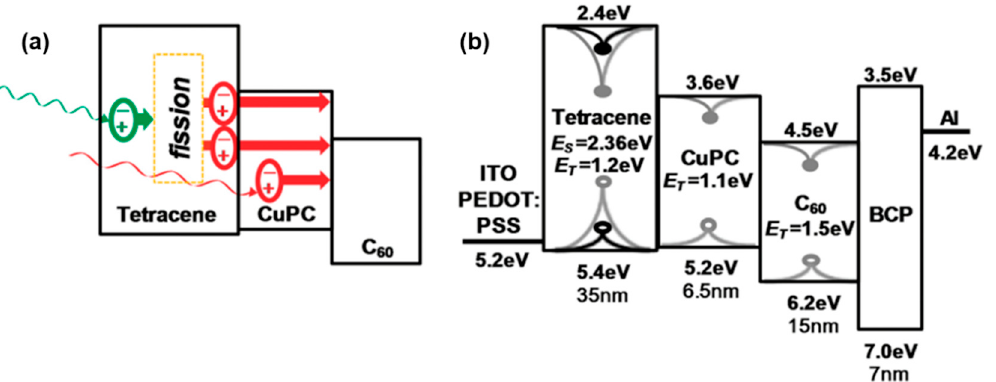
Figure 14. ( a ) Schematic of a photovoltaic exhibiting the SF process. ( b ) Complete structure of the photovoltaic cell. Reprinted with permission from Ref. [95]. Copyright 2011, American Chemical Society.